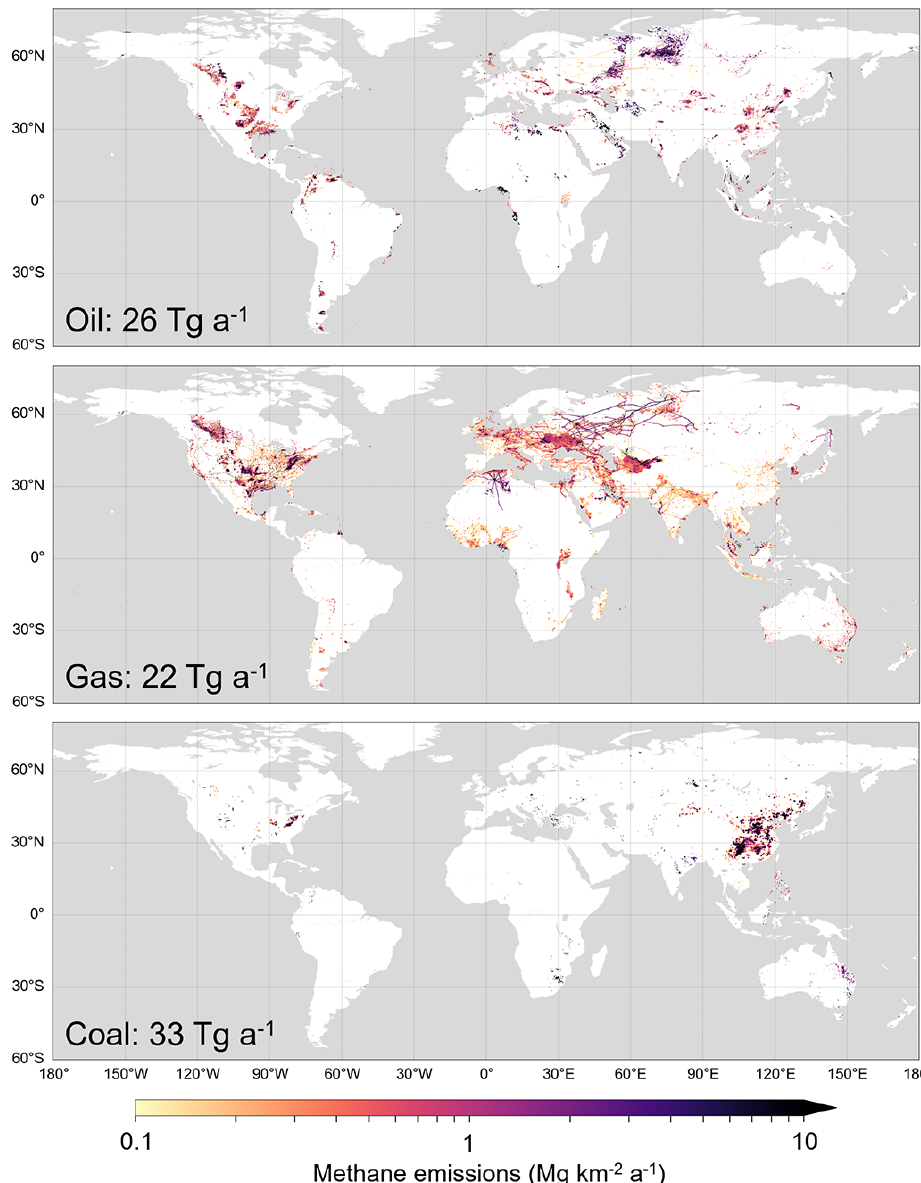
Figure 1. Methane emissions from oil, gas, and coal exploitation in GFEI v2 for 2019. Emissions are at 0.1 ◦ × 0.1 ◦ grid resolution with global emissions inset. Emissions below 0.1Mgkm − 2 a − 1 are not